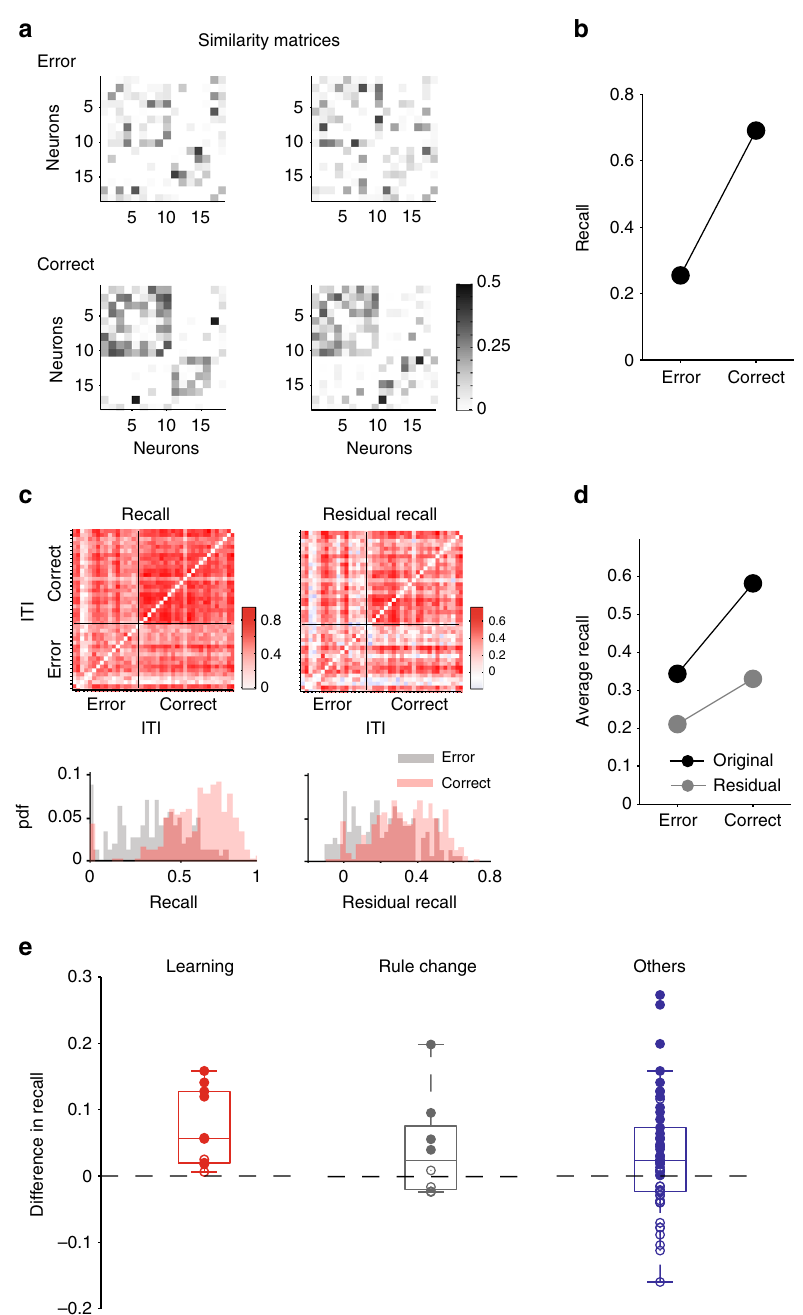
Fig. 2 Outcome-selective recall of an ensemble activity pattern is learning-related. a Example similarity matrices for neural population activity during inter- trial intervals (same examples as Fig. 1b). b Example comparison of ensemble activity between inter-trial intervals. “ Recall ” R(t,u) is the similarity between the core population ’ s similarity matrices in intervals t and u . For the matrices in panel a, the recall is lower following errors than following correct choices. c Example of consistent recall after reinforcement in one session. Left: the recall matrix R for the session, each entry the recall value R(t,u) for inter-trials intervals t and u . The recall matrix is ordered by the outcome of the preceding trial. Below we plot the probability density functions for the distribution of recall values, for the post-error pairs of intervals (bottom-left block diagonal in the recall matrix) and for the post-correct pairs of intervals (top right block diagonal in the recall matrix). Right: the residual recall matrix for the same session, after correction for the effects of interval duration. d The average recall values for post-error and post-correct intervals of the two matrices in c . The distribution of recall in the post-correct intervals was higher than in the